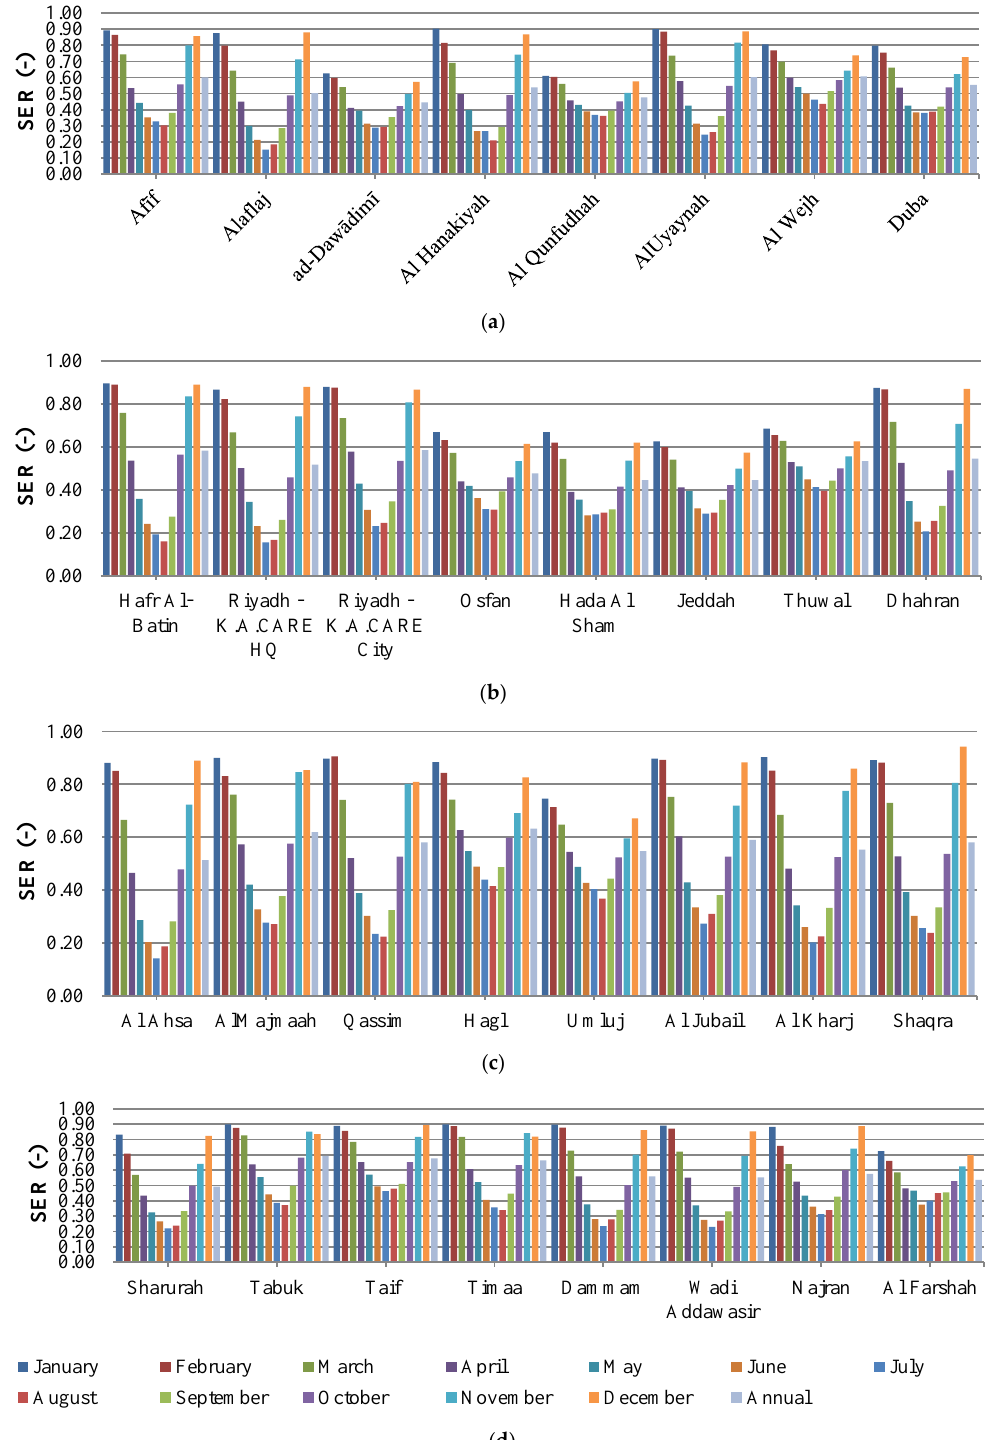
Figure 10. Monthly variations of sensible energy ratio for ( a ) Afīf, Alaflaj, ad-Dawādimī, Al Hanakiyah, Al Qunfudhah, AlUyaynah, and Al Wejh, Duba; ( b ) Hafr Al-Batin, Riyadh—K.A. CARE HQ, Riyadh—K.A. CARE City, Osfan, Hada Al Sham, Jeddah, Thuwal, and Dhahran; ( c ) Al Ahsa, AlMajmaah, Qassim, Hagl, Umluj, Al Jubail, Al Kharj, Shaqra; ( d ) Sharurah, Tabuk, Taif, Timaa, Dammam, Wadi Addawasir, Najran, and Al